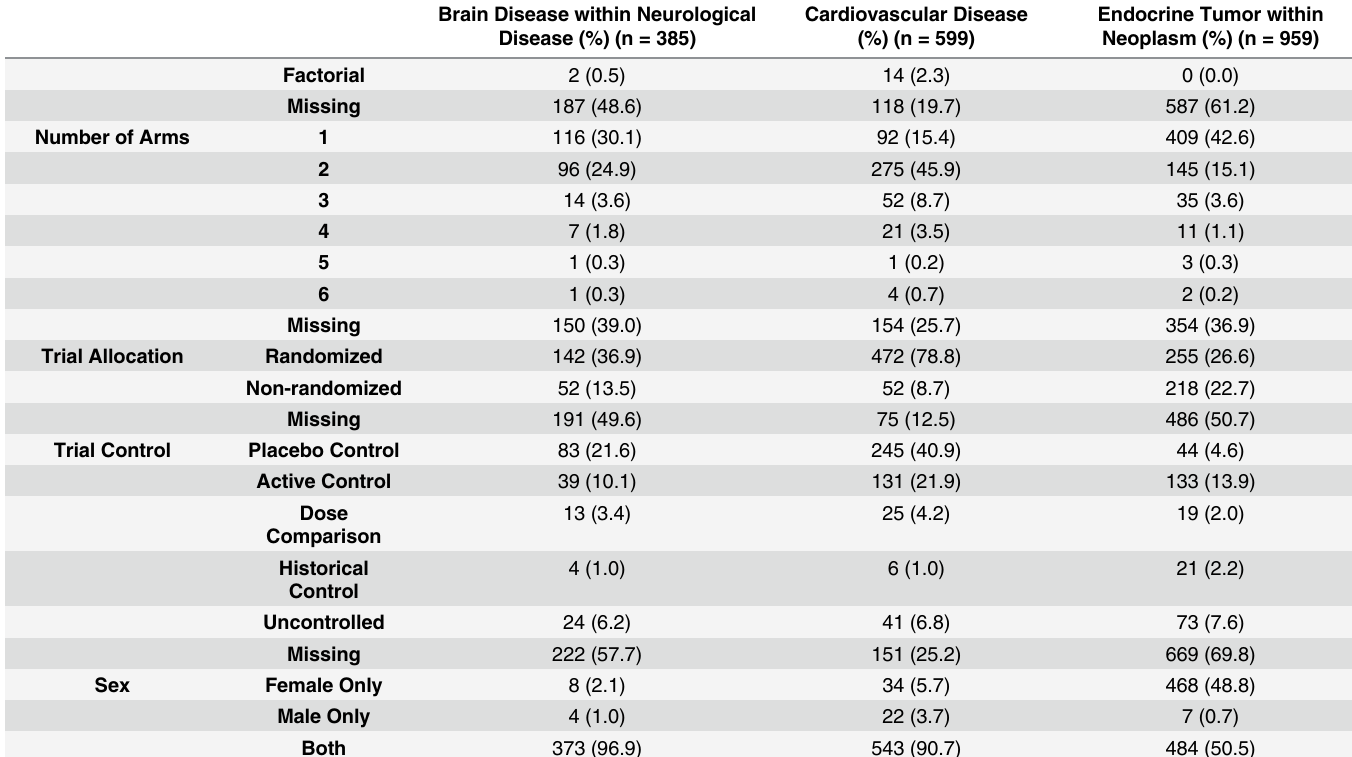
cardiovascular disease trials, parallel groups accounted for 314/599 (52.4%). In endocrine tumor trials, single groups accounted for 282/959 (29.4%), but missing data accounted for 587/ 959 (61.2%) trials. Trial arms were predominantly (with about 60%) one- and two-armed trials among the three therapeutic areas. One-armed trials were the most frequent among brain dis- ease and endocrine tumor trials, with 116/385 (30.1%) and 409/959 (42.6%), respectively. In cardiovascular disease trials, two-armed trials accounted for 275/599 (45.9%). Allocation dif- fered by specialty. Cardiovascular disease trials were mostly randomized, with 472/599 (78.8%), whereas brain disease and endocrine tumor trials were less so, with 142/385 (36.9%) and 255/959 (26.6%), respectively. However, there were missing data for about 50% of trials for the latter two specialties. The trial control was also different among these areas. Brain disease and cardiovascular disease trials were mostly conducted using placebo controls, with 83/385 (21.6%) and 245/599 (40.9%), respectively. Endocrine tumor trials were mostly performed using active controls, with 133/959 (13.9%). However, over 50% of brain disease and endocrine tumor trials had missing data. Trials included both sexes, except for endocrine tumor trials; half of these were for breast or ovarian cancers and therefore included only females. According to cross-analysis between trial purposes and phases, most brain disease and endocrine tumor trials were for treatment and from early phase through phase 2 (Fig 1). Car- diovascular disease trials for the purpose of treatment showed two peaks, one for early phase (phases 1 to 2) and another for late phase (phases 3 to 4) trials. In the cross-analysis between trial purpose and participants, all three therapeutic areas were dominated by low enrollment numbers (20 – 50 participants) and were for the purpose of treatment (Fig 2).